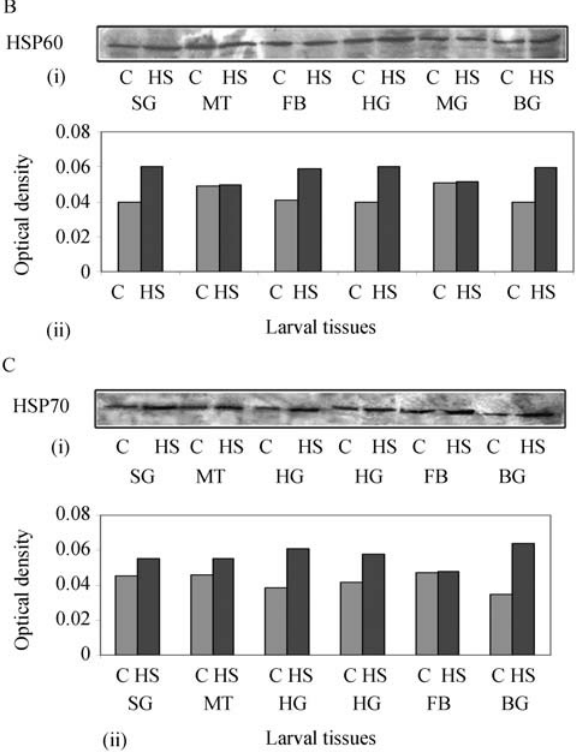
Figure 1B - (i). Western blot showing HSP60 expression in salivary gland (SG), Malpighian tubule (MT), fat body (FB), hindgut (HG), midgut (mg) and brain ganglia (BG) tissues of larval M. domestica (N = 15) at the control (C, 25 °C) and heat shock temperature (HS, 42 °C). (ii) Histogram showing densitometric optical density (OD) measurement of band intensity for the corresponding western blot lanes shown in (i) above. Figure 1C -(i). Western blot showing HSP70 expression in salivary gland (SG), Malpighian tubule (MT), hindgut (HG), midgut (mg), fat body (FB) and brain ganglia (BG) tissues of larval M. domestica (N = 15) at control (C, 25 °C) and heat shock temperature (HS, 42 °C). (ii) Histogram show- ing densitometric optical density (OD) measurement of band intensity in the corresponding western blot lanes shown in (i) above.